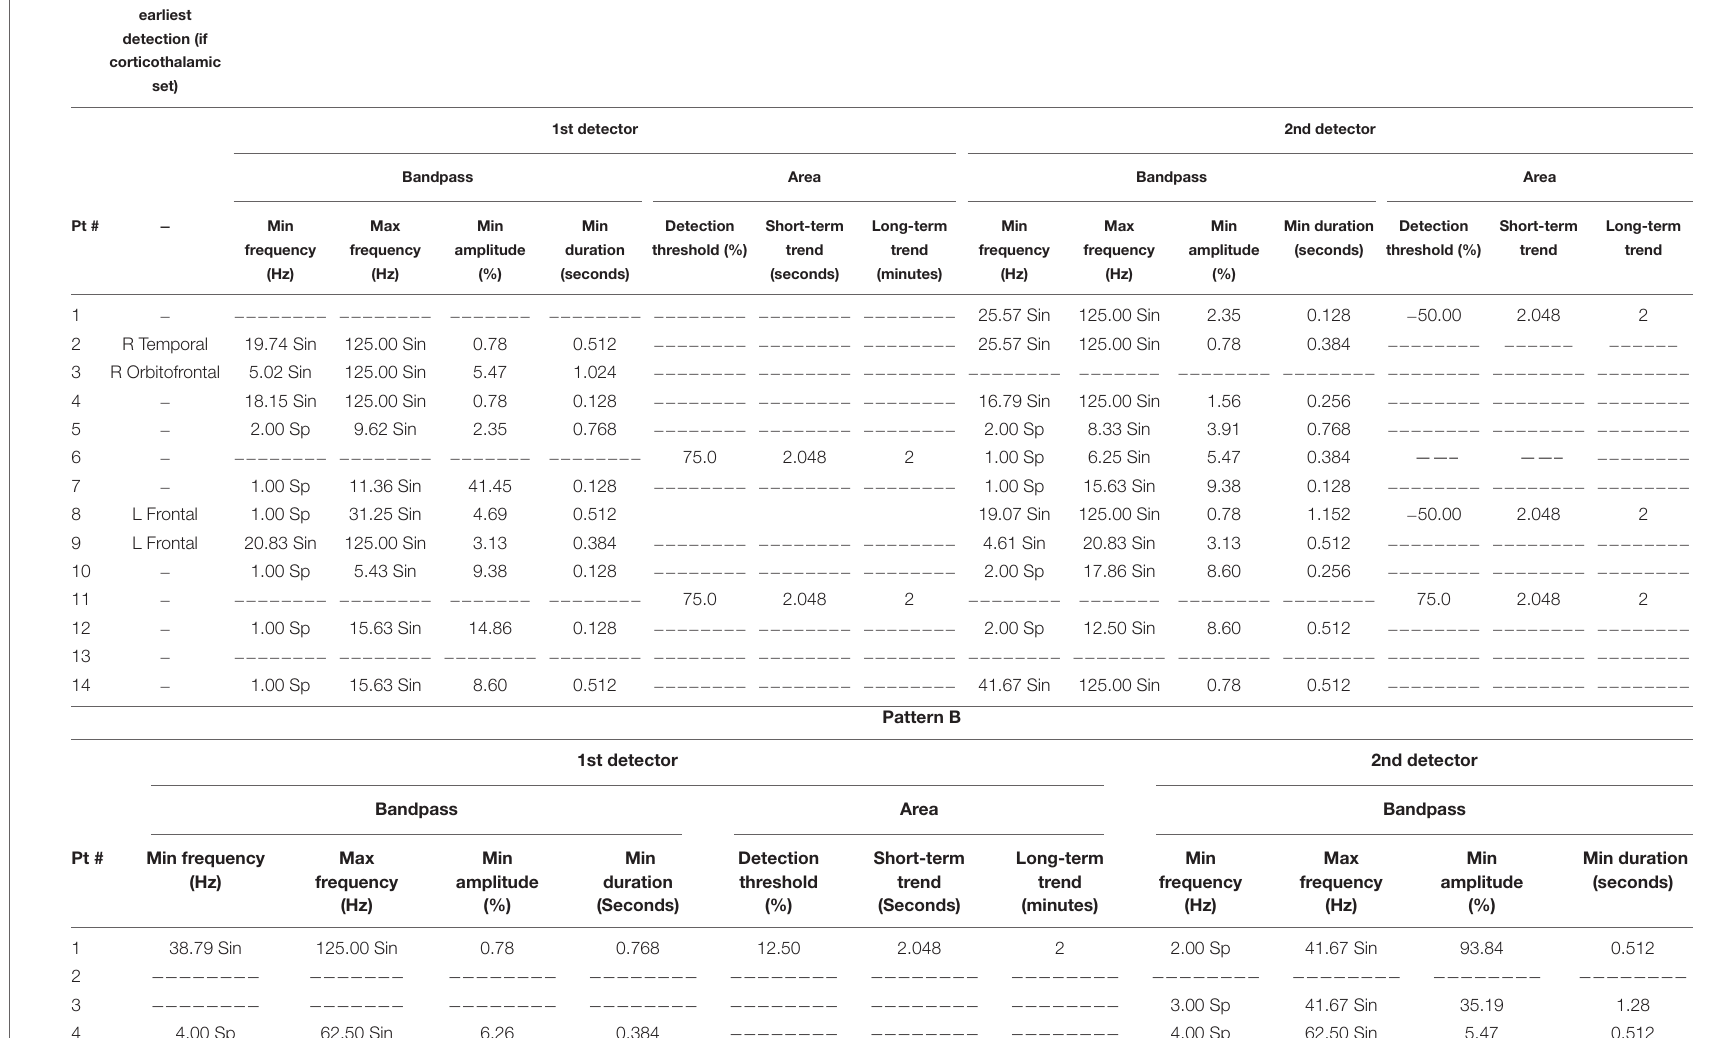
TABLE 2 | Detection settings. Lead with earliest detection (if